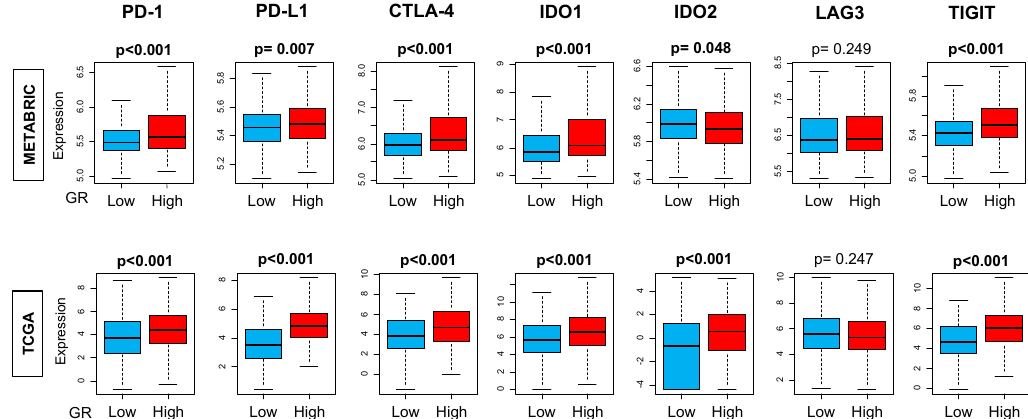
Figure 5. Immune exhaustion gene markers in GR-high and GR-low groups using CIBERSORT algorithm in the entire cohort. The cut-off of top and bottom quartile of NR3C1 expression was considered as GR high and GR low in the entire cohort. Y -axis shows the fraction of cells with GR-low or GR-high expression. All boxplots are of Tukey type, and the boxes depict medians and interquartile ranges. Depicted p values are calculated using one-way ANOVA. PD-1, programmed death-1; PD-L1, programmed death ligand 1/2; CTLA-4, cytotoxic T-lymphocyte-associated protein 4; IDO, indoleamine 2,3-dioxygenase; LAG3, lymphocyte activation gene 3; TIGIT, T cell immunoreceptor with Ig and ITIM domains.